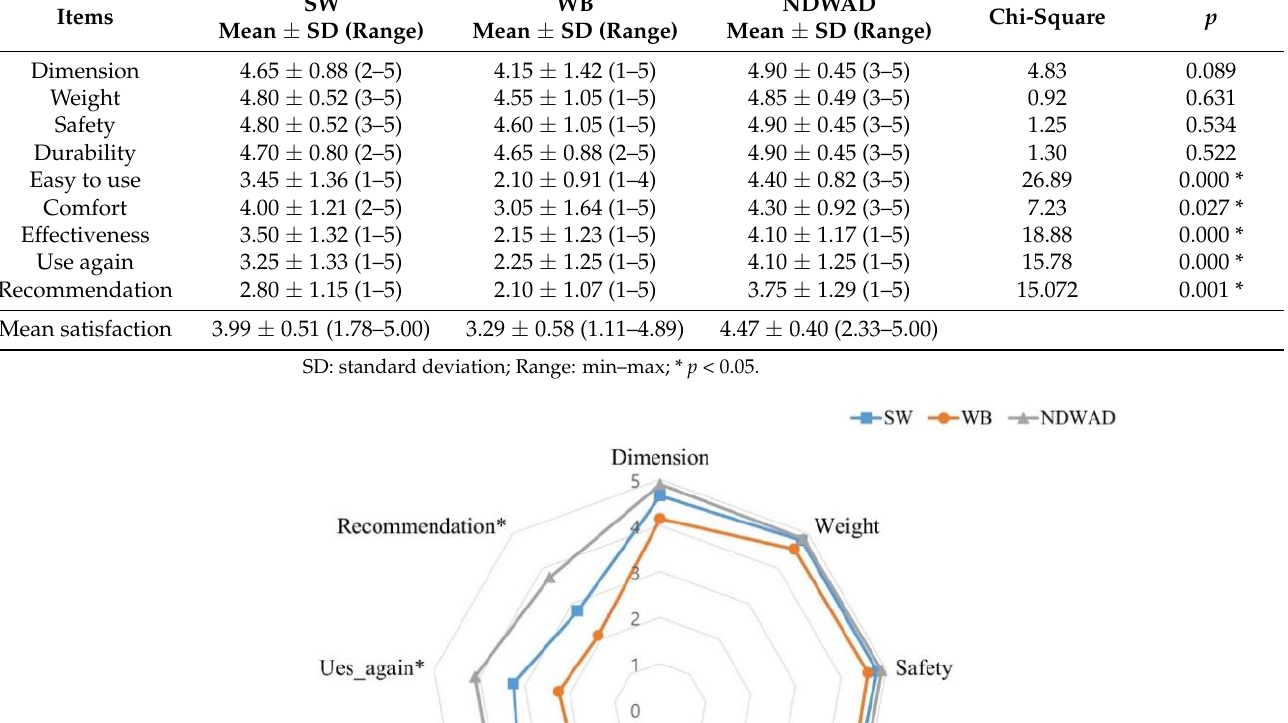
9 of 14 Item: question items for satisfaction evaluation. Table 8 and Figure 7 show the evaluation results of nine questions relating to satis-